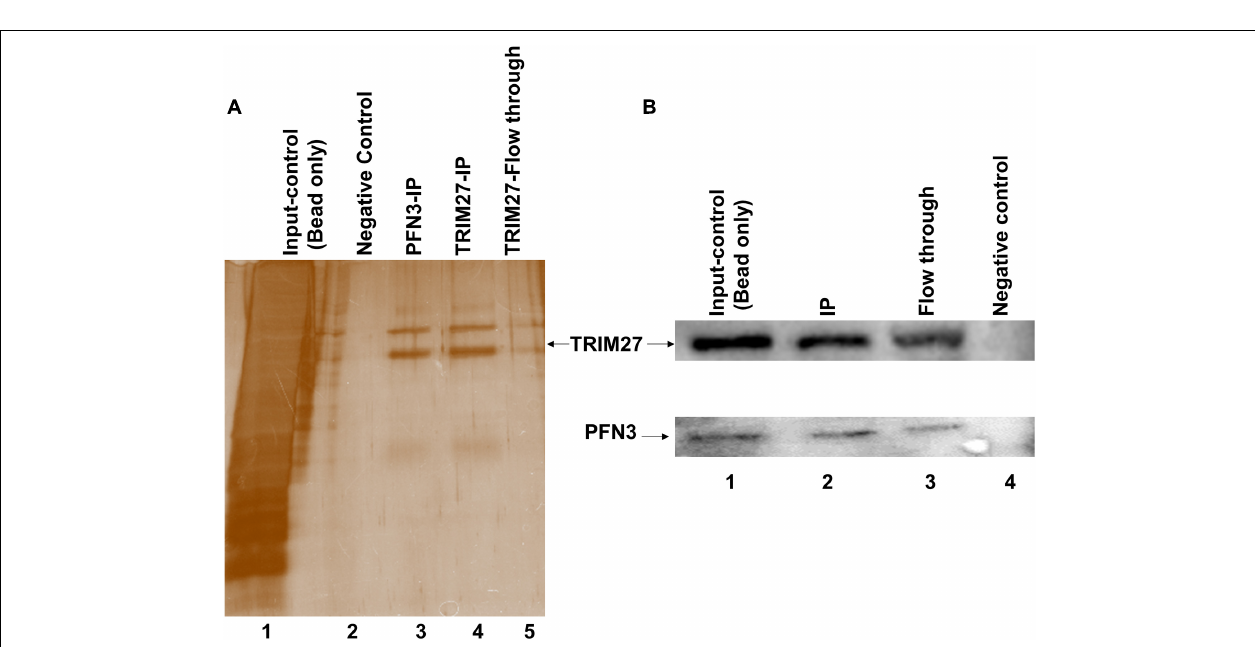
FIGURE 8 | Disruption in autophagic flux and AMPK/mTOR signaling pathway of Pfn3 -deficient mice. (A) Immunoblot analysis against ATG2A, LC3B, SQSTM1, mTOR, phospho-mTOR, and phospho-AMPK α on protein lysates from Pfn3 + / + , Pfn3 + / − , and Pfn3 − / − testes. (B) Immunohistochemical staining against phospho-mTOR on Pfn3 + / + , Pfn3 + / − , and Pfn3 − / − testis sections (top row). (C) Immunohistochemical staining against LC3B on Pfn3 + / + , Pfn3 + / − , and Pfn3 − / − testis sections (bottom row). Staining of testicular tissue sections from Pfn3 + / + (left column), Pfn3 + / − (middle column), and Pfn3 − / − (right column) animals is shown. Scale bar = 100 µ m.